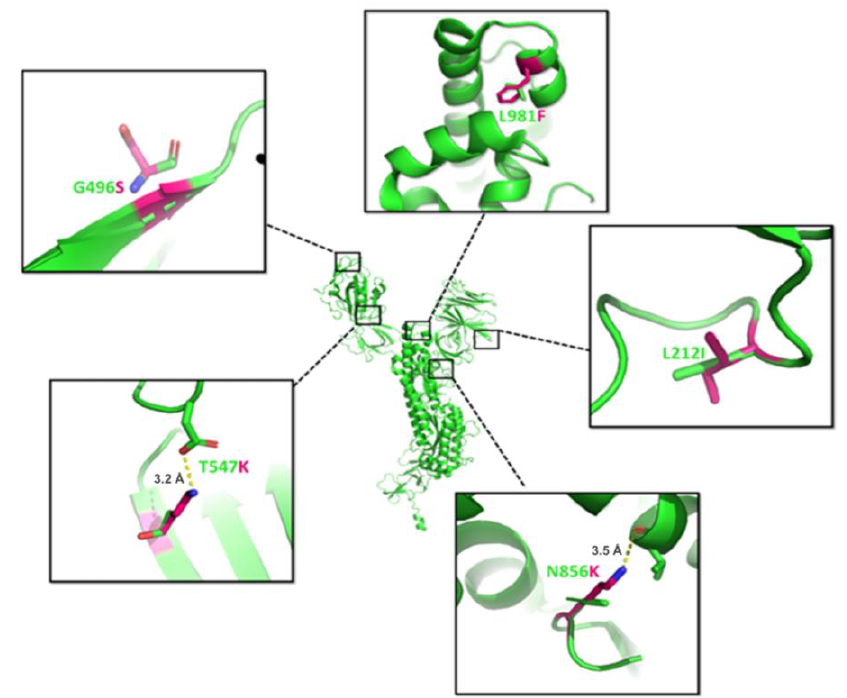
Figure 10. The structure of the spike (PDB: 6VXX) is shown in green (center). The dotted line is magnified to represent the results of L981F, L212I, N856K, T547K, and G496S mutations, where the mutated amino acid is shown in magenta and wild-type amino acids as green sticks. The length between residues is shown in units of Angstrom (Å).